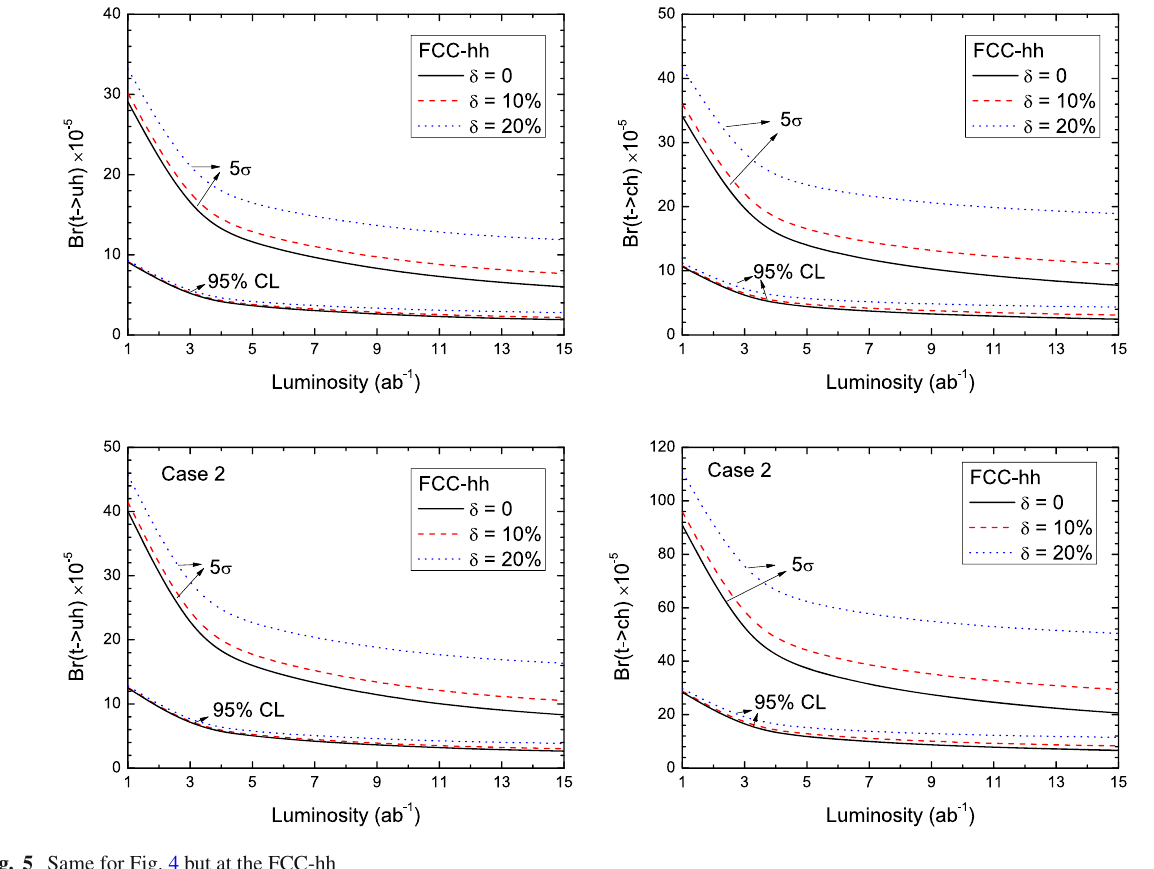
Fig. 5 Same for Fig. 4 but at the